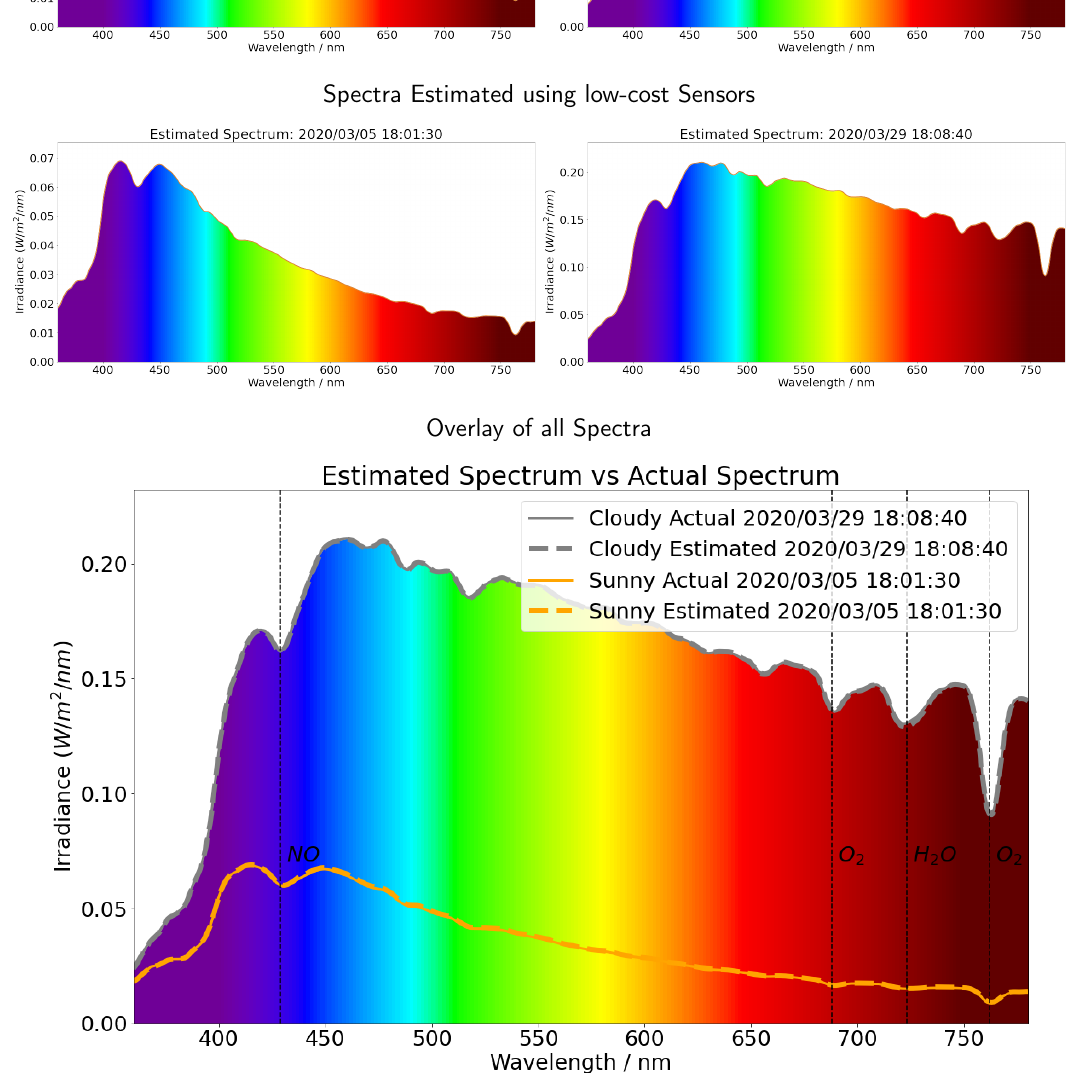
Figure 10. The full spectrum intensity (middle panel) predicted using the data from the low-cost sensors, and the full spectrum ANN compared with the spectra observed by the reference sensor (upper panel). The daily spectra over the entire day have been shown in Section 5. We can clearly observe the role of the variable weather conditions, such as changing cloudiness. It was sunny on 5 March 2020, and this can be observed by noting the higher spectral irradiance at the shorter wavelengths, indicating a blue sky day. In comparison, it was cloudy on 29 March 2020. Note how the spectral irradiances from the blue to red portion of the spectrum are much more similar than on March 5; the sky was closer to white than blue. Our ANN performed well for both clear sky and cloudy conditions, and the data from the low-cost sensors could be used to effectively reproduce the full spectra, including the atmospheric absorption